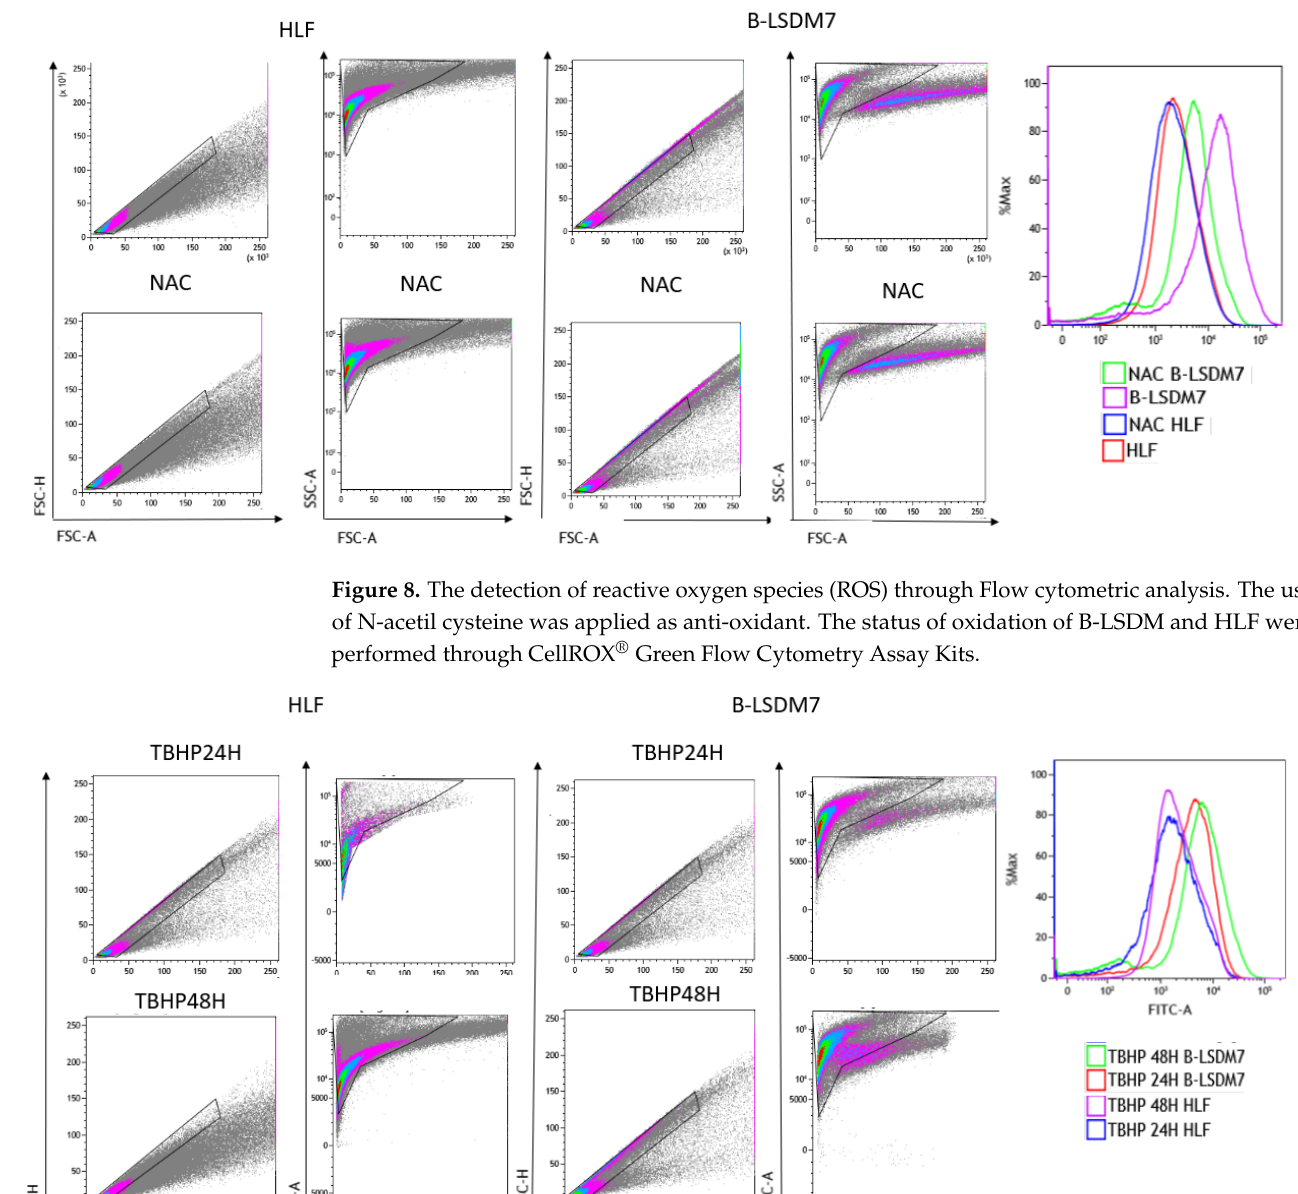
Figure 10. The detection of reactive oxygen species (ROS) and viability of cells following oxidation were performed through Flow cytometric analysis. Sytox Red was used to detect dead cells. The status of oxidation of B-LSDM and HLF were performed through CellROX® Green Flow Cytometry Assay Kits. 4. Discussion